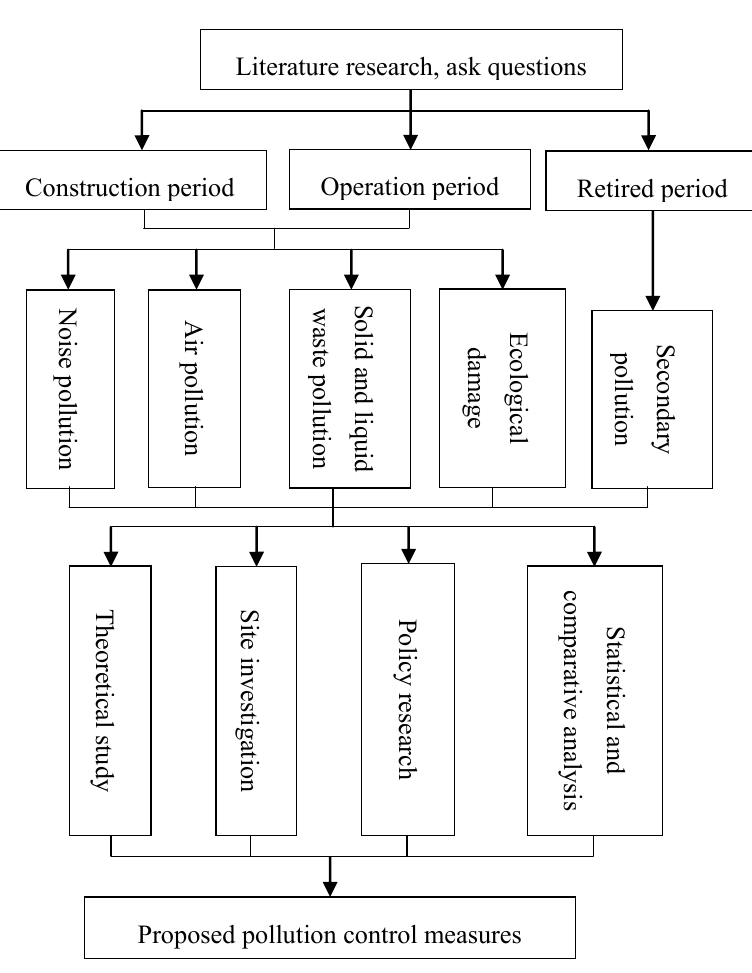
Figure 1. Research Procedures and